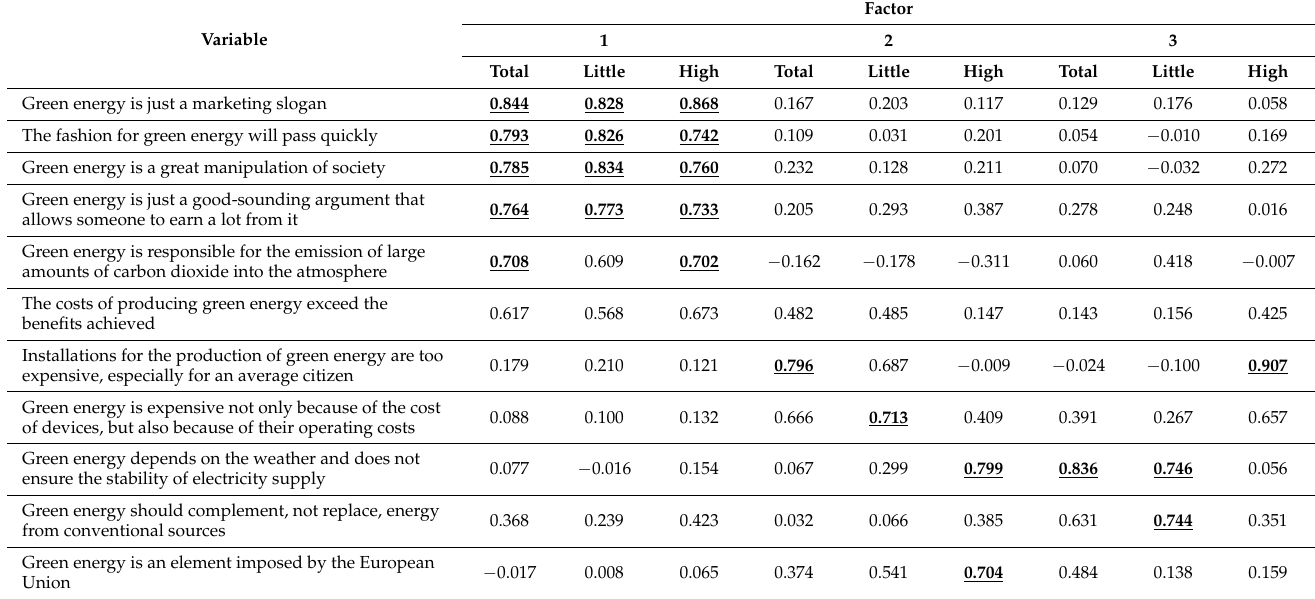
Table 7. Results of the factor analysis of respondents’ associations with green energy reflecting the level of their market awareness, and the self-assessment of their level of knowledge about green energy.